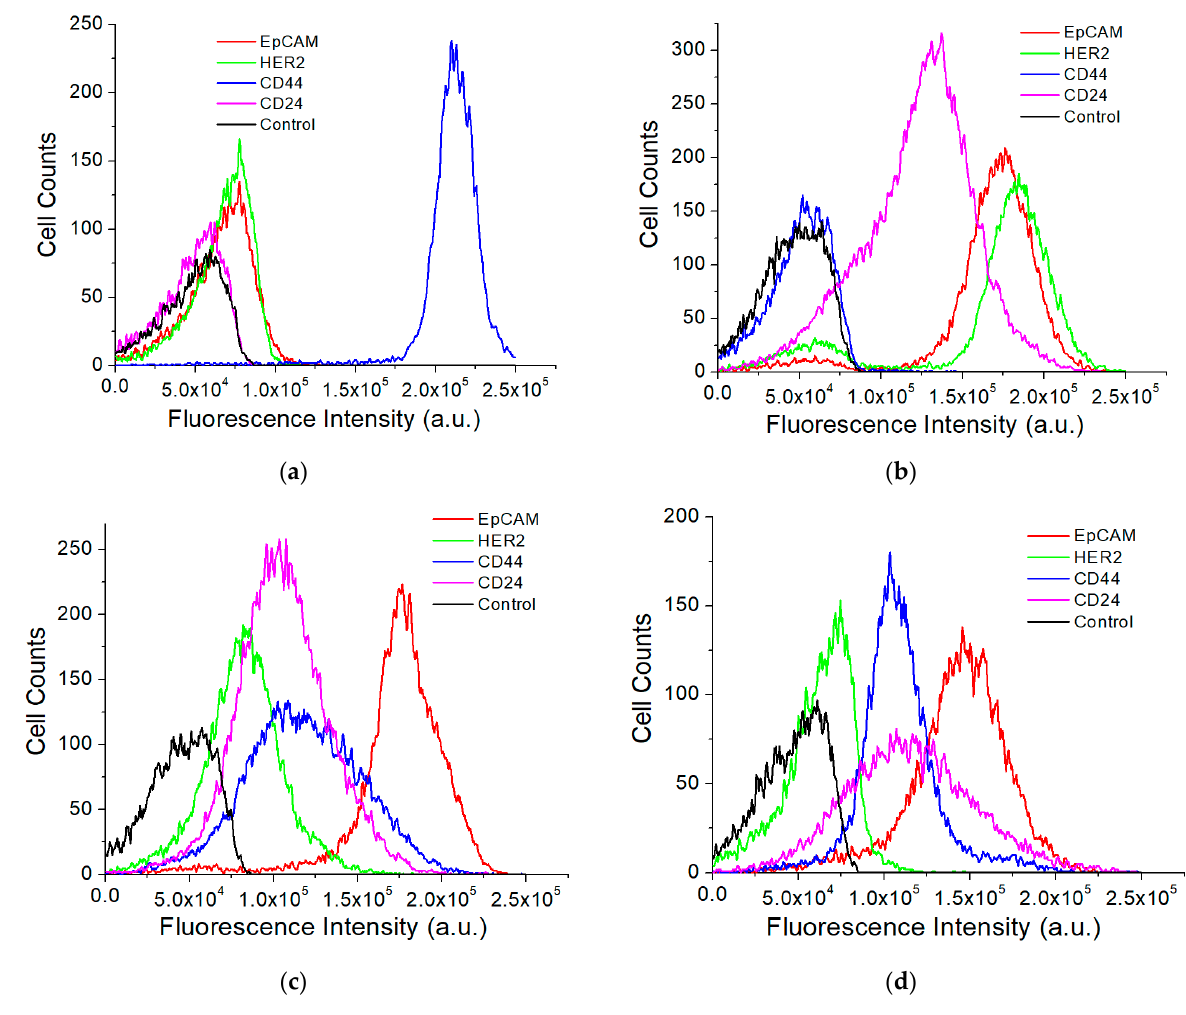
Figure 4. Flow cytometry analysis of different cell surface protein markers for MDA-MB-231 ( a ), SKBR3 ( b ), and MCF7 ( c ) breast cancer cell lines and normal breast cell line MCF12A ( d ).